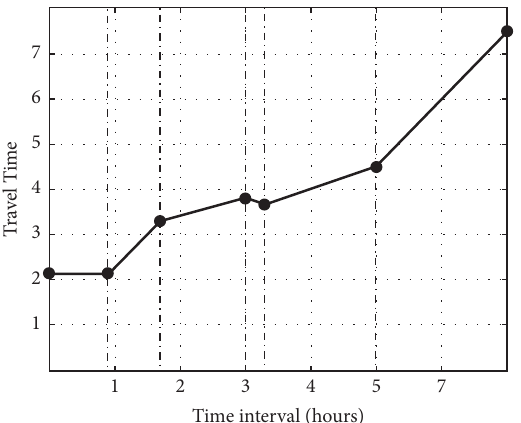
Figure 2: An example of ‘‘passing” with discrete travel time